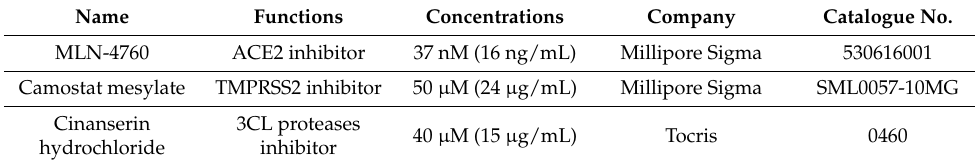
Table 3. Inhibitors potentially targeting receptors or proteases of